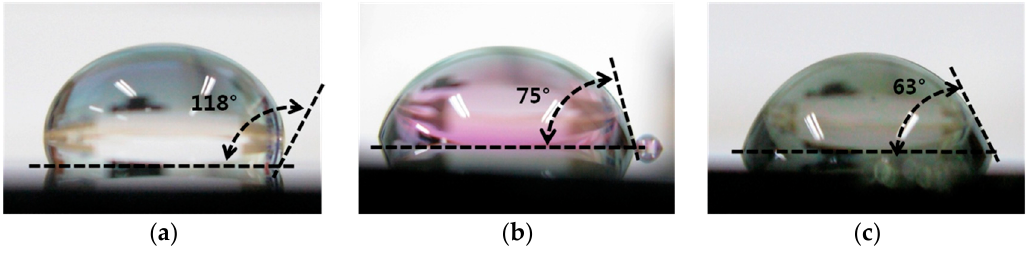
Figure 7. Photographs measuring contact angles of: ( a ) Teflon; ( b ) SU-8; and ( c ) polyimide (PI). First, an SU-8 coating layer with a thickness of 0.5 µm was applied through a heat treatment for 60 s, at 373 K on a hot plate after spin coating (3000 rpm, 30 s). Subsequently, Teflon, with a thickness